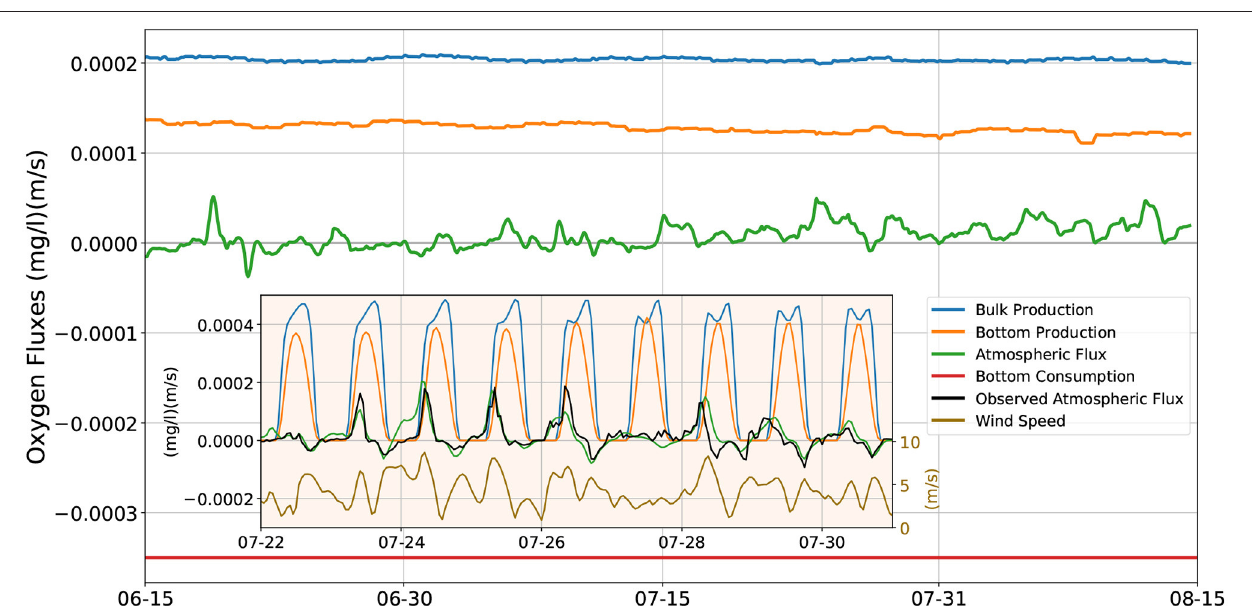
FIGURE 6 | O 2 fluxes in and out of the water column. Positive values denote O 2 flux into the water column, negative fluxes are out of the water column. Main figure: model’s daily averaged fluxes; blue line: vertically integrated bulk photosynthetic production; orange line: photosynthetic production at the bottom of the water column; green line: flux to/from the atmosphere at the top of the water column; red line: constant respiratory consumption of the benthos/nepheloid layer. Inset figure: instantaneous fluxes during a period of recurring hypoxia events. Blue, orange, green lines: as for the main figure; black line: fluxes to/from the atmosphere computed using the dissolved O 2 and temperature values observed at midwater; dark yellow line: wind speed (right